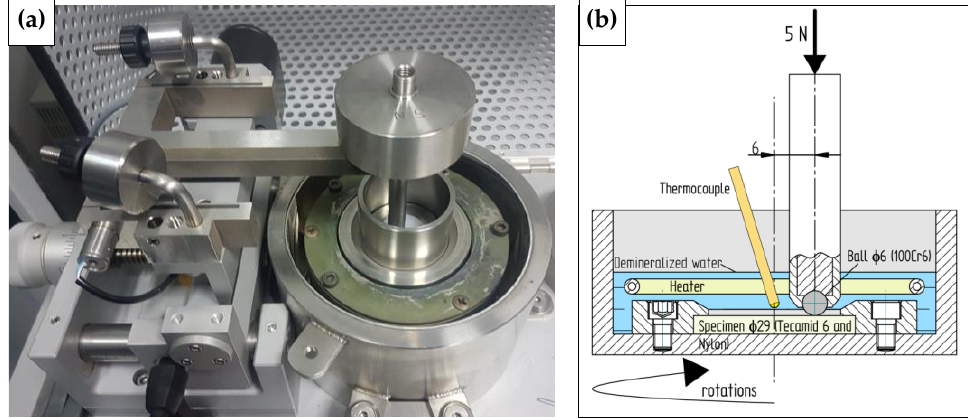
Figure 5. THT tribometer test setup (dry sliding friction) ( a ) and CSM tribometer test scheme (friction in demineralized water at 50 ◦ C ( b ). Table 2. Sliding friction test parameters.